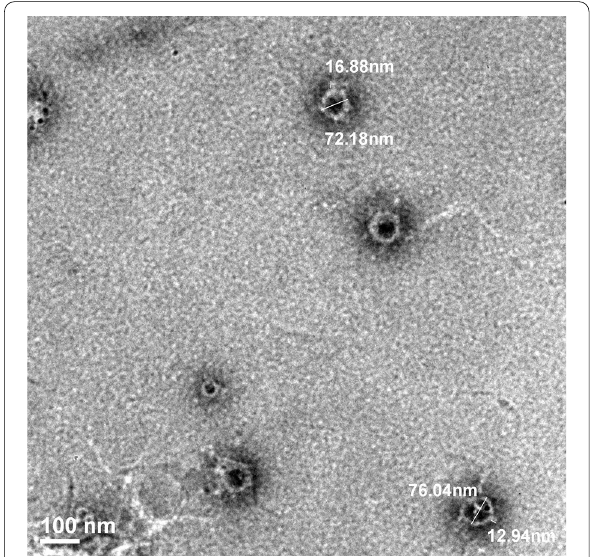
Fig. 3 TEM analysis showed that KpG phages belonged to the family Podoviridae . Triple purified Phage lysate of high titer was stained with 2% uranyl acetate and visualized under FEI transmission electron microscope (Model JEM 2100F Jeol, Japan). Image presented is representative of multiple